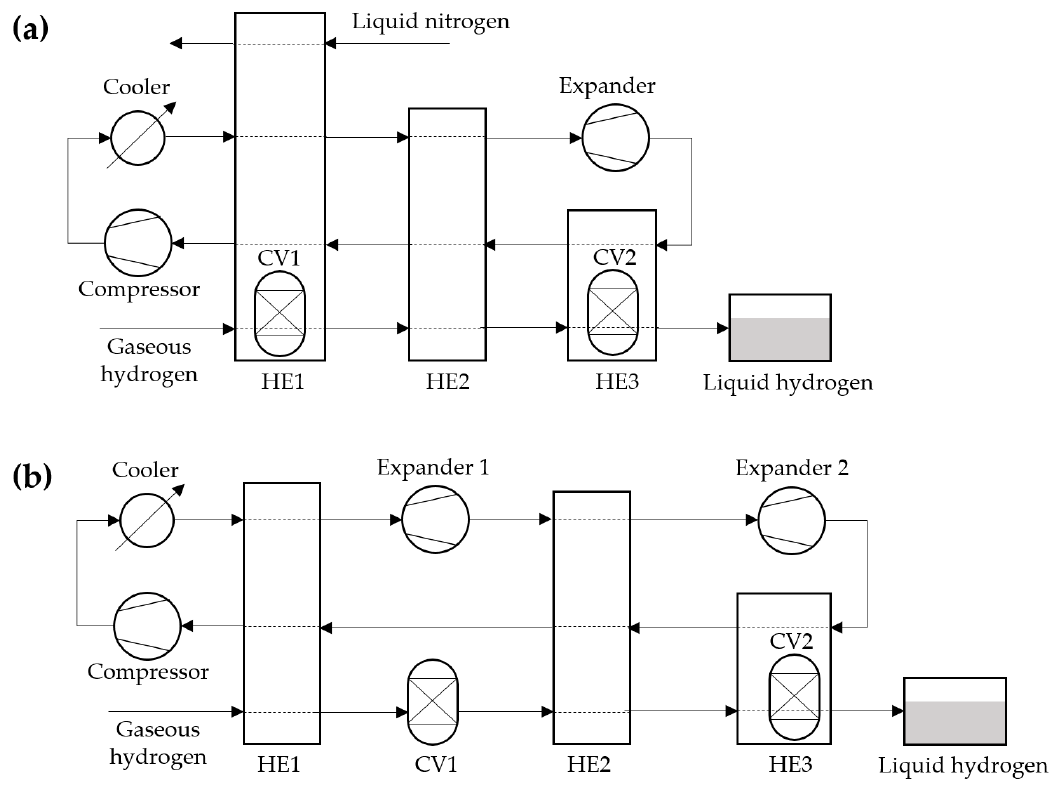
Figure 10. Schematic diagram of possible installation of ortho- to-para-hydrogen converter in: ( a ) helium Brayton cycle with liquid nitrogen pre-cooling, and ( b ) two-step helium Brayton cycle [67].